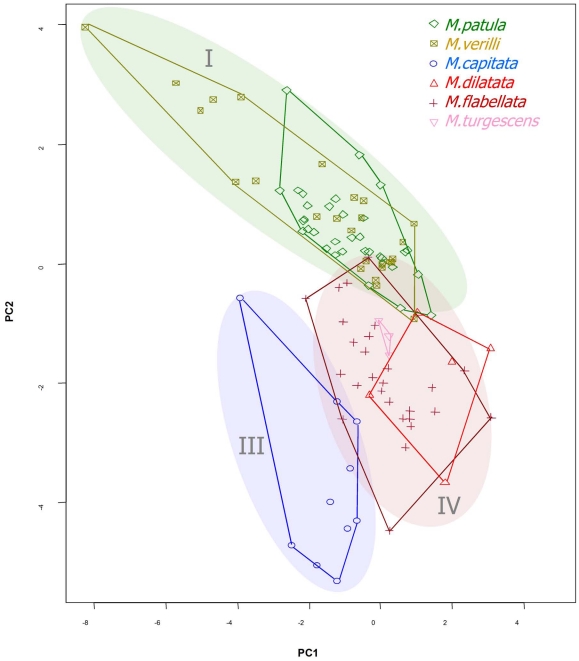
PCA plot of fine-scale morphological traits.A plot of the first two principal components color coded by species; background colors indicate genetic groups.